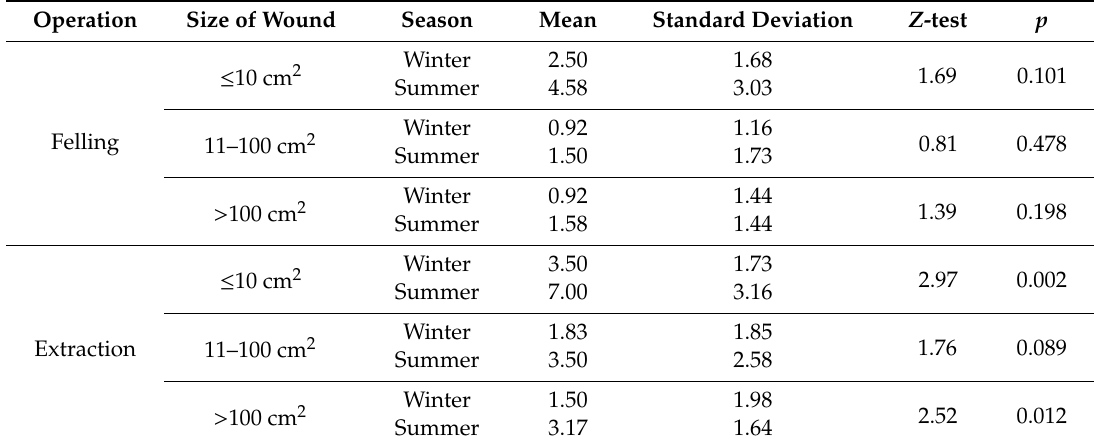
Table 3. Number of damaged trees in particular wound size categories.